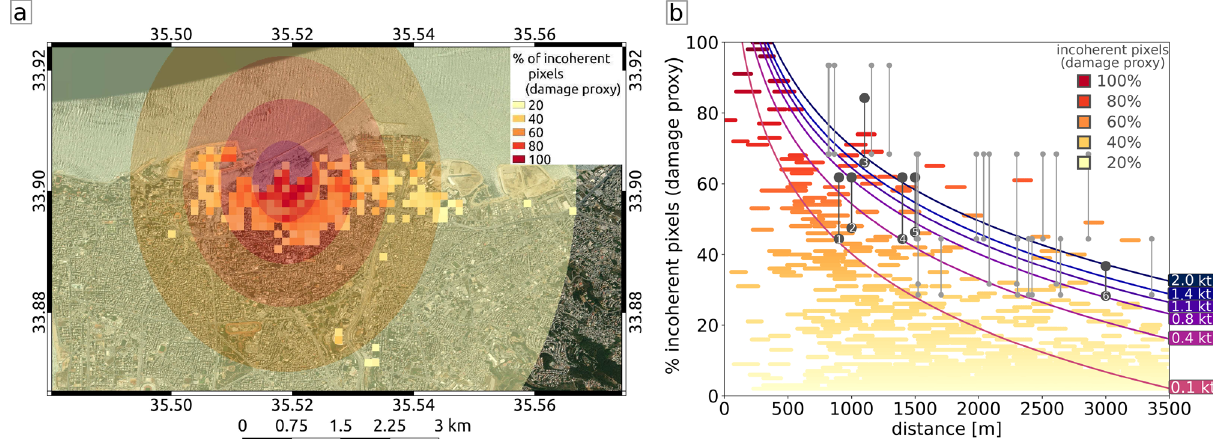
Figure 4. Yield estimation through comparison of approximated and estimated damage over distance from the explosion site. ( a ) Damage proxy (colored pixel) and expected damage map over an optical satellite image background (Sentinel-2). The damage proxy is percent of pixels that experienced significant loss of interferometric coherence after the explosion in a windowed damage pixel of 100 m by 100 m size. The transparent overlay indicates the radii of the expected damage from a yield of 0.8 kt TNT and is colored after the relative damage classes 22 . Map background was created using basemap data from the Esri ArcGIS Map Service. ( b ) Measured damage and expected damage for several evaluated yields over distance from the explosion site. “Yield estimation from InSAR damage maps” section Eq. 3 is evaluated for yields of 0.1, 0.4, 0.8, 1.1, 1.4 and 2.0 kt of TNT at the distances of the damage pixels and plotted as lines. Damage proxy is plotted as in ( a ). Vertical lines mark damage proxy estimations for reported damage which we relate to peak overpressure at locations given in Table 4 (black, with numbers) and from a dedicated damage survey 23,24